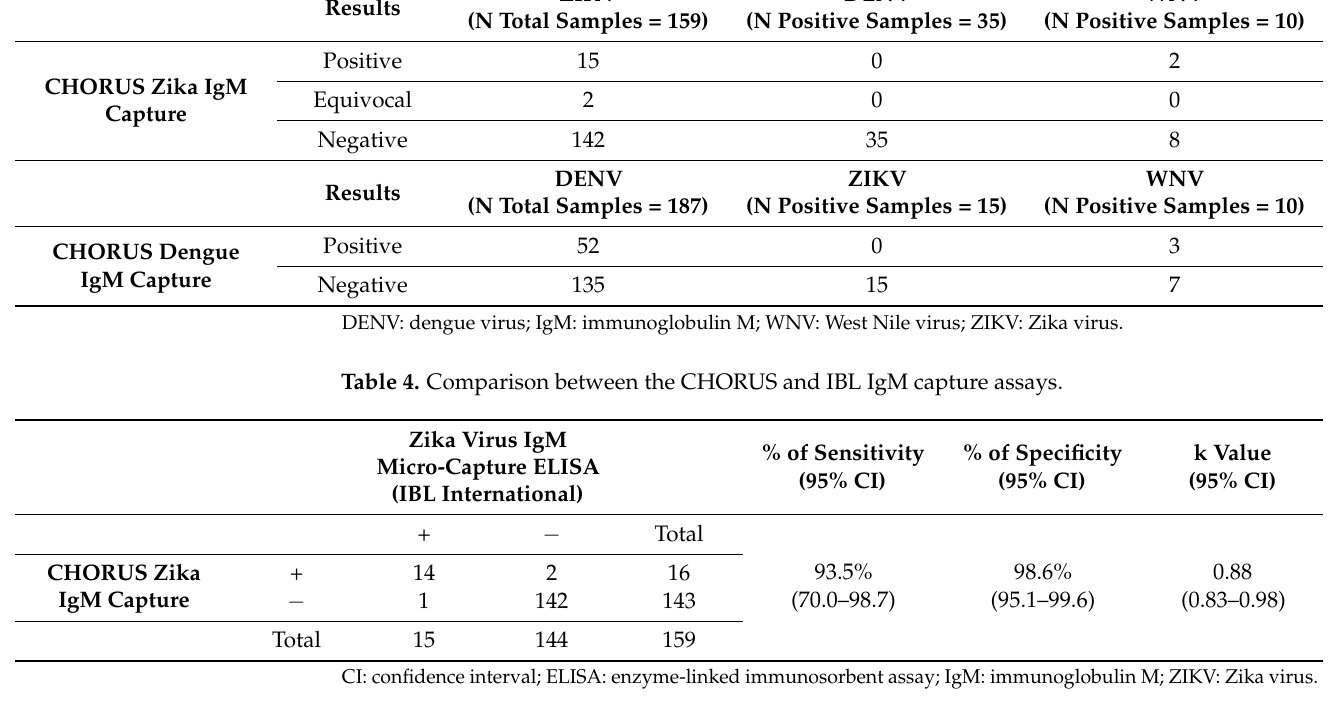
Table 5. Comparison between the CHORUS and Panbio Dengue IgM Capture ELISA.